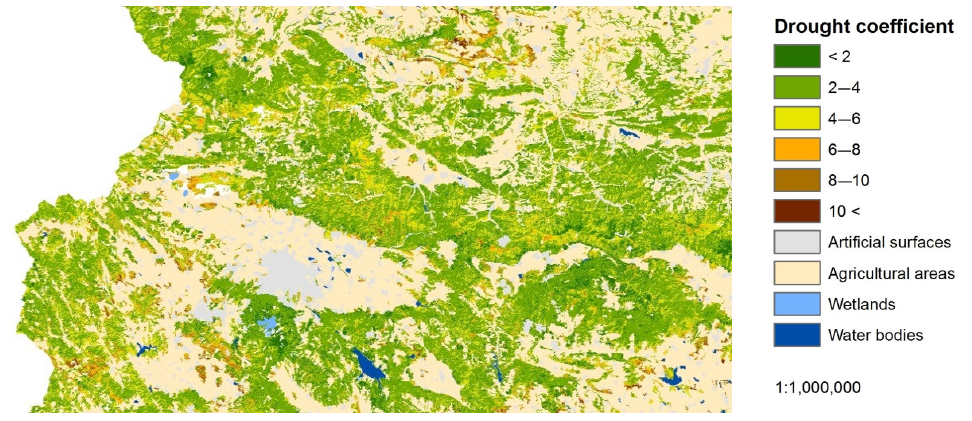
Forests 2021 , 12 , x FOR PEER REVIEW 13 of 33 Figure 2. Distribution of DC in the beginning of August. Figure 2. Distribution of DC in the beginning of August.